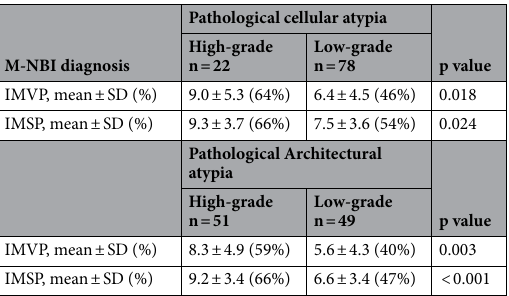
Table 5. Association between M-NBI findings and pathological atypia. Pathological cellular and architectural atypia were classified as high-grade and low-grade and the mean ± SD (%) of 14 endoscopists who diagnosed IMVP and IMSP were